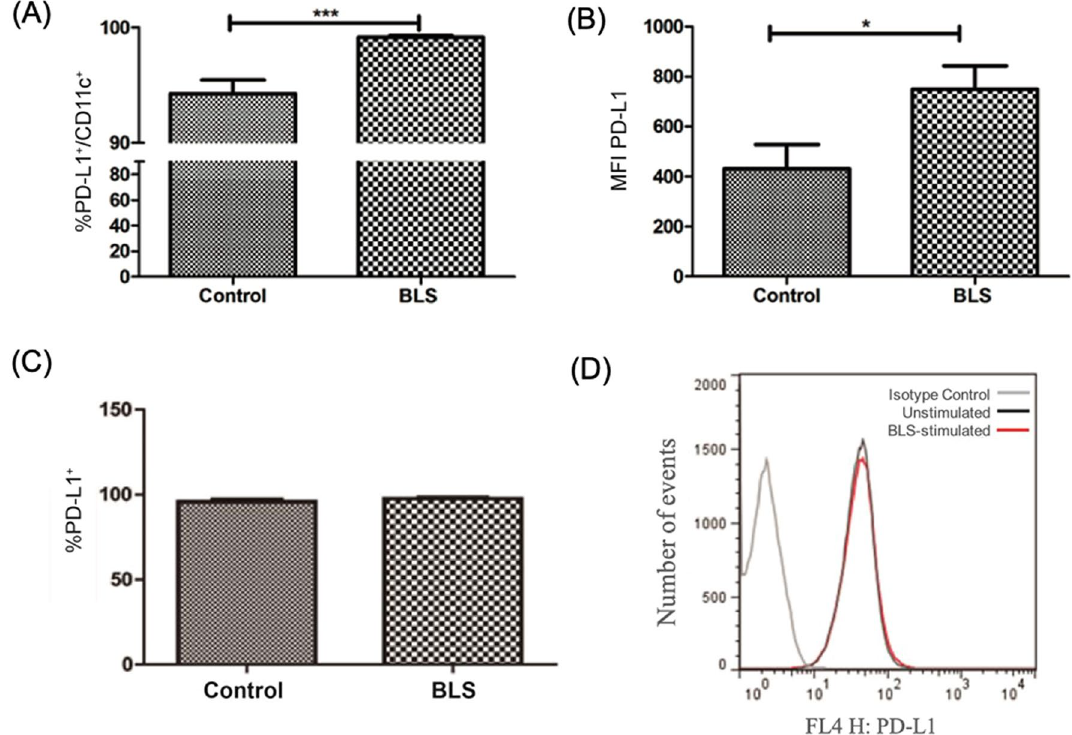
Figure 5. PD-L1 expression on BMDC and B16 cells upon BLS stimulation . BMDC from C57BL/6J ( A , B ) mice were generated and stimulated with BLS or non-stimulated (control) for 18 h. B16 cells ( C , D ) were cultured with BLS or non-stimulated (control) for 48 h. Level of expression of PD-L1 was evaluated by flow cytometry. Three different experiments were pooled (n = 2 replicates per experiment).